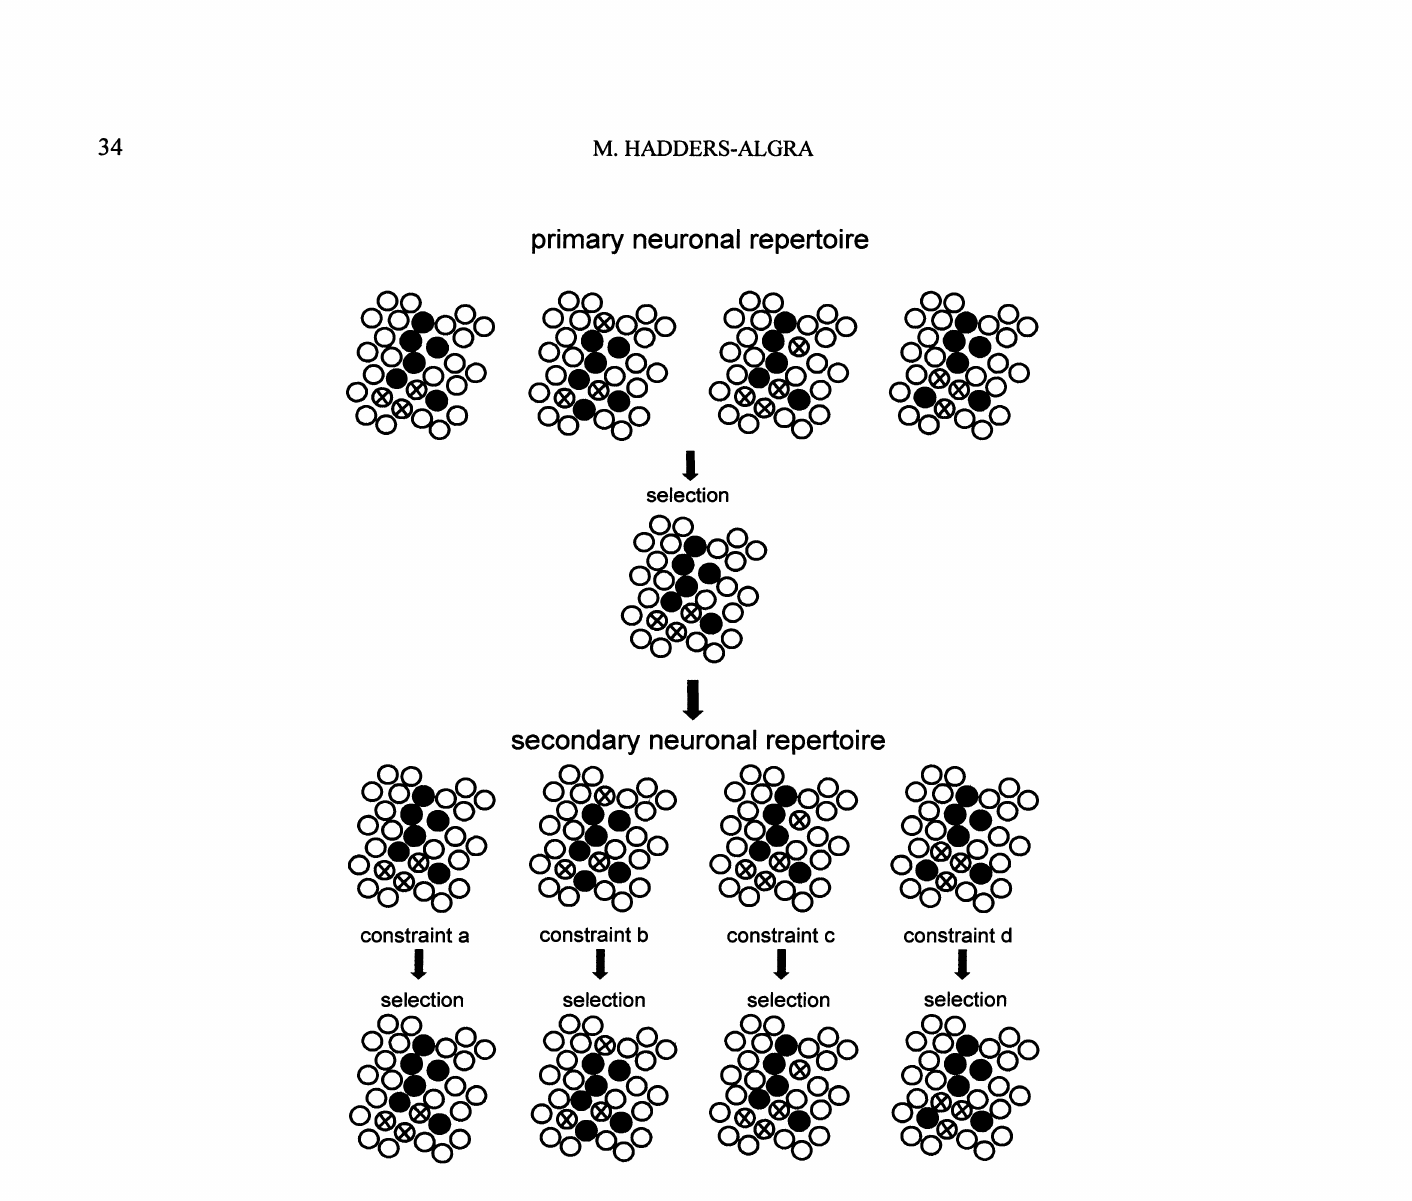
Fig. 1: Schematic representation ofEdelman’s Neuronal Group Selection Theory. Each circle represents a cluster of supraspinally localized neurons, i.e., the neurons are localized in cortical, cortico-striato-thalamo-cortical, or cortico-cerebellar-cortical networks. At the upper row, neural activity is depicted at early age at four closely spaced points in time. The filled circles (= and (R)) denote neurons genetically determined to control a specific type of motor behavior, that is, they reflect a primary neuronal repertoire. For instance, the filled circles could denote neurons controlling the motoneurones of the muscles on the ventral side of the body which are genetically determined to be in charge of postural control during a backward sway of the body (direction-specificity). The open circles (O)represent neurons genetically linked to other types of behavior, i.e., other primary neuronal repertoires. At the four different points in time, the filled primary neural repertoire is activated in four different configurations, i.e., four different neuronal groups--denoted by the different grades of filling ofthe clusters (O active;